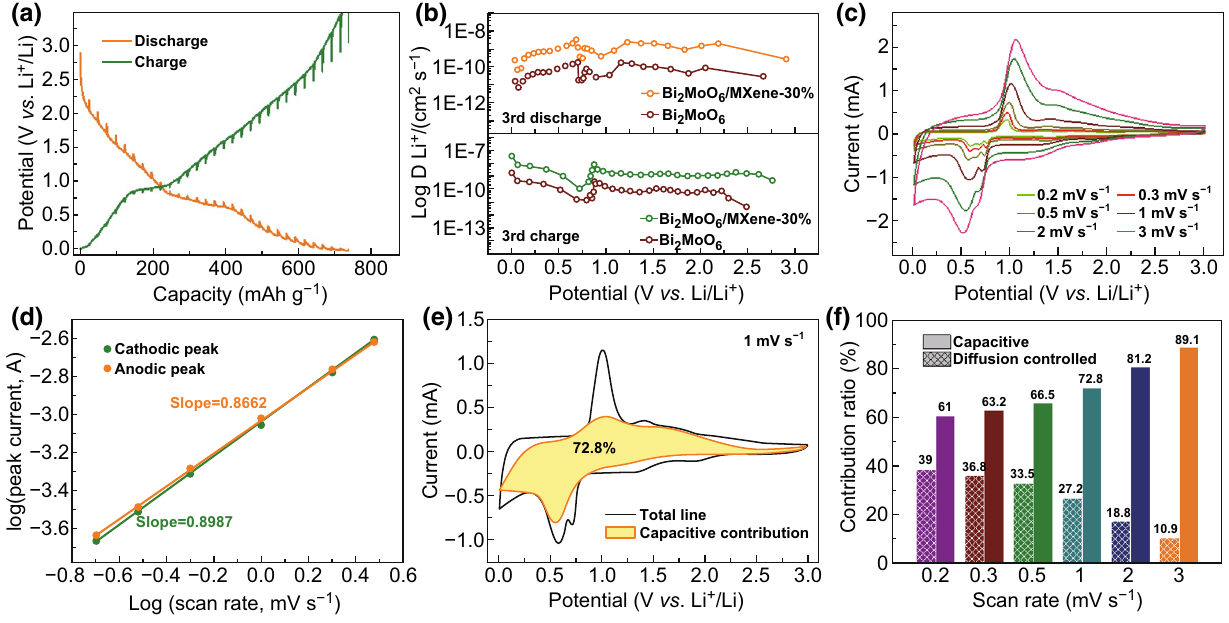
Fig. 6 Electrochemical kinetic analysis of Li storage behavior of Bi 2 MoO 6 /MXene‑30%. a GITT profiles (current pulse at 100 mA g −1 for 30 min followed by 1 h relaxation), b diffusion coefficients calculated from GITT profiles according to overpotential, c CV curves at various scan rates from 0.2 to 3 mV s −1 in the voltage range of 0.01–3 V (vs. Li + /Li), d log( i )–log( v ) curves, e CV profile measured at 1 mV s −1 with shaded area displaying the pseudocapacitive contribution, and f normalized proportions of capacitive and diffusion‑controlled contribution at various scan